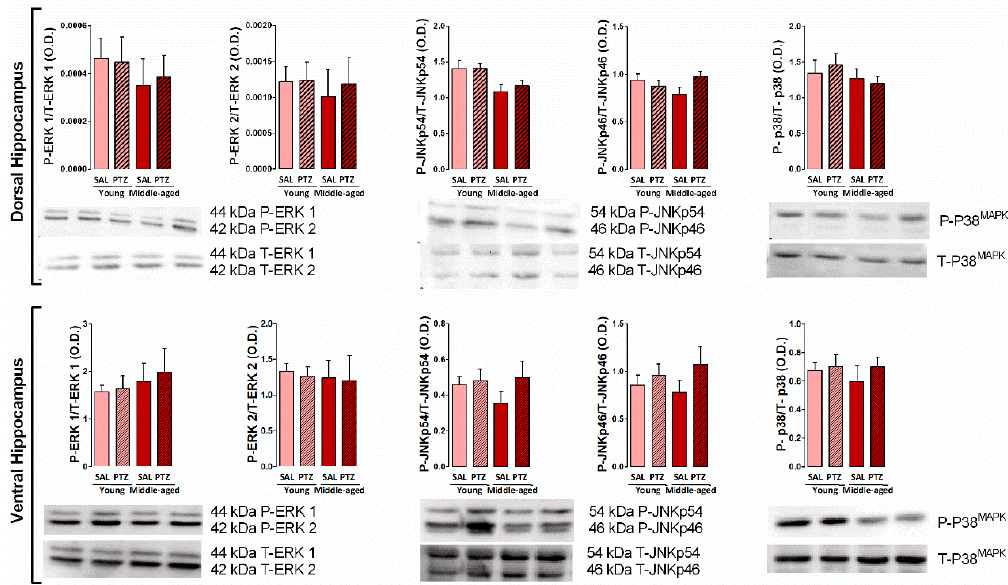
Figure 4. Effects of kindling on expression of mitogen-activated protein kinases (MAPKs) (ERK 1/2, JNK p54/p46, p38) into the dorsal and ventral hippocampus of middle-aged rats. Values are represented by the mean + S.E.M. followed by two-way ANOVA ( n = 6/group).